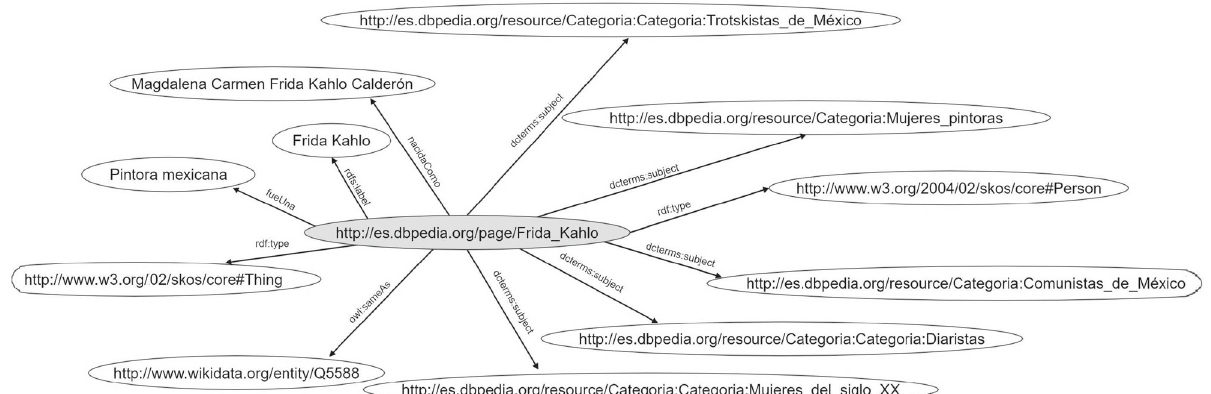
Fig. 4 The constructed KG